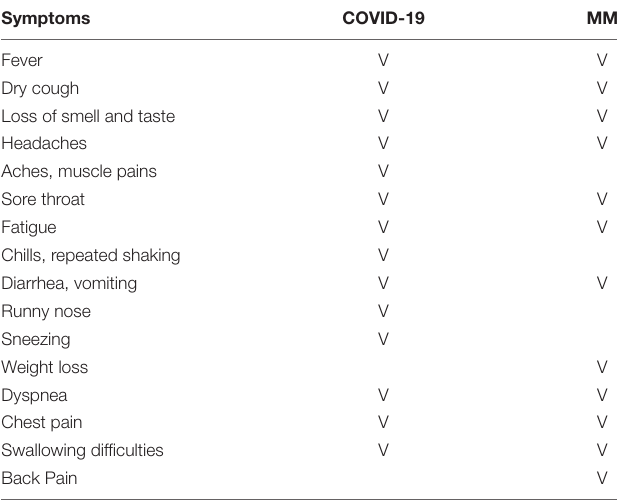
TABLE 1 | Comparison between COVID-19 and MM